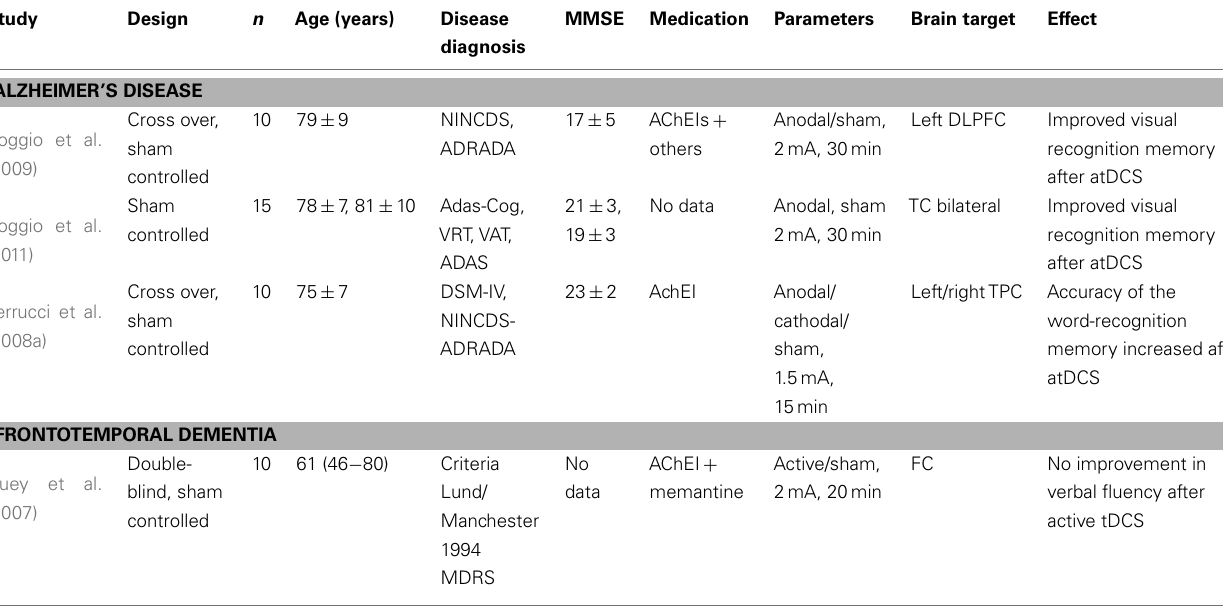
Table 1 | Clinical studies of tDCS in